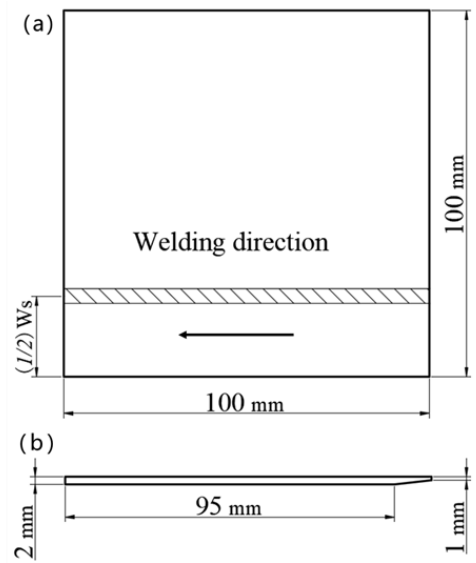
Figure 3. Method to determine the value of the starting edge of the welding process (W S ). ( a ) The front of the specimen; ( b ) the profile of the specimen.